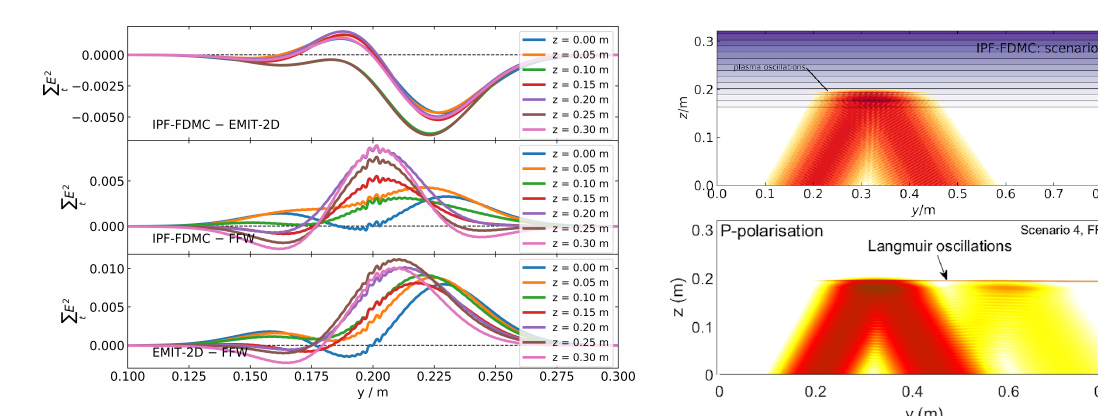
Figure 5. Full-wave simulation results for scenario #4, shown is a snapshot of the squared wave electric